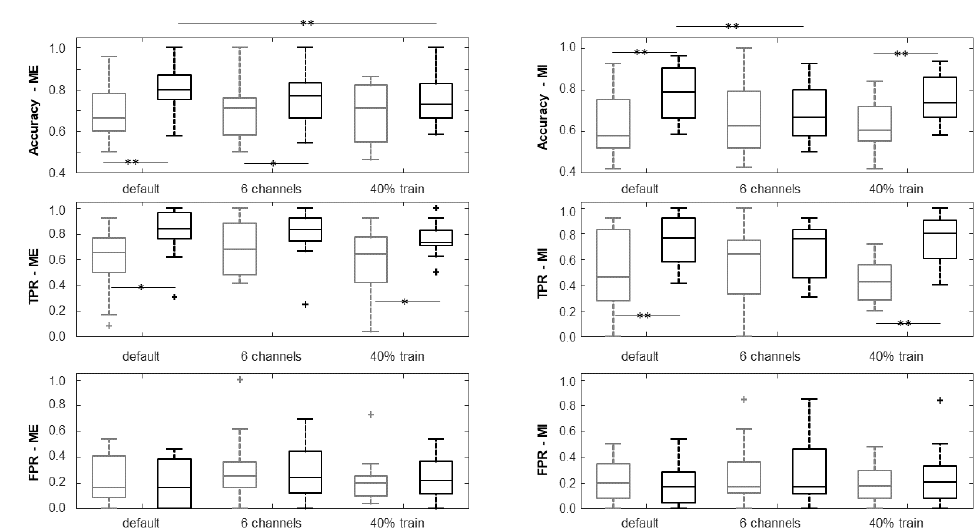
Figure 5. Performances on the testing set of the filters: non-linear spatial filter (NL-SF, gray color) and adapted non-linear spatio-temporal filter (NLSTF, black color). Accuracy, true positive rate (TPR) and false positive rate (FPR) are shown, considering either motor execution (ME) or imagination (MI). The default condition (i.e., nine EEG channels and 70% of training data) is compared with the reduction of either the number of channels (six instead of nine channels) or the size of the training set (40% of the MRCPs instead of the 70%). Box and whiskers plots are shown, indicating median, quartiles, range and outliers (using +markers). Statistical differences in paired comparisons are shown with marker * ( p < 0.05) or ** ( p < 0.01) and a segment joining the two tested